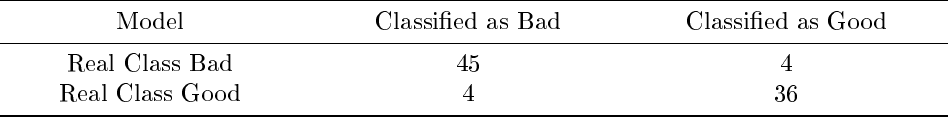
Table 3: Multilayer Perceptron Results (tested in subset